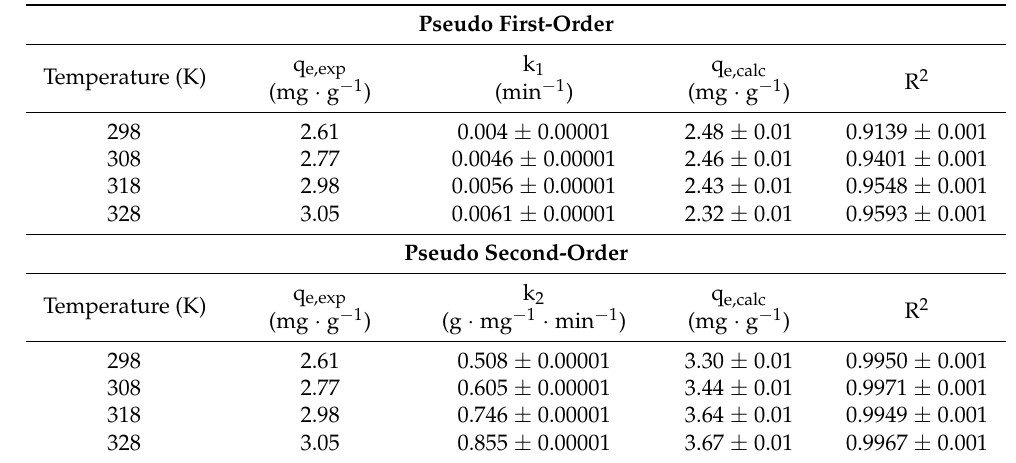
Table 1. Kinetic parameters for adsorption of Pd(II) onto XAD7-DB18C6 material.